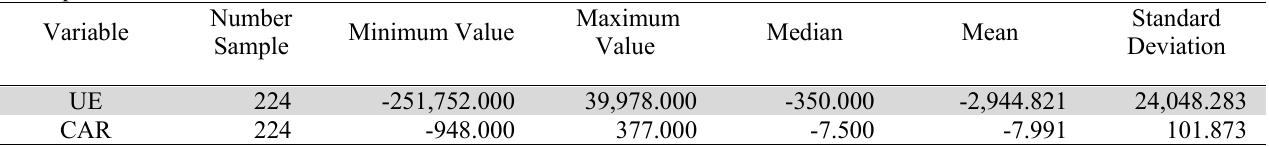
Descriptive Statistics of EU and CAR Variables